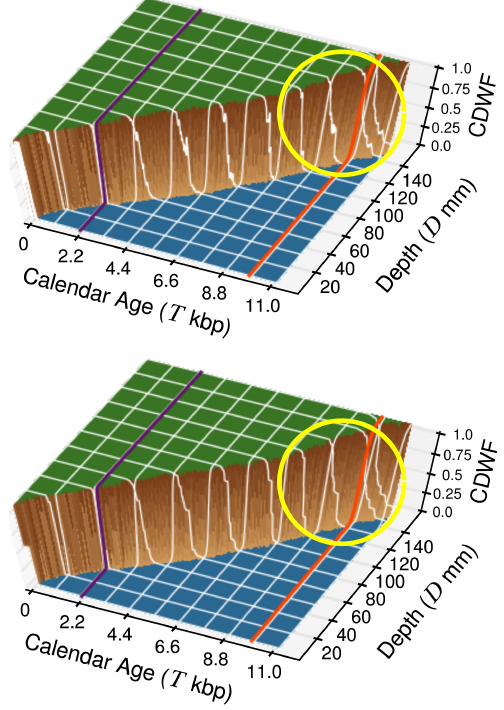
Figure 3. The age–depth sea cliff. (a) The initial CDWF W i ob- tained using Eq. (5), and (b) the final CDWF W f obtained af- Fig. 3. The age-depth sea-cliff. A. The initial CDWF W i obtained ter imposing monotonic growth, for the same example as used in using Eq. 5, and B. the final CDWF W f obtained after imposing Fig. 2. Values of W = 0 are shown in blue and, for W = 1, they are monotonic growth, for the same example as used in Fig. 2. Values shown in green. Intermediate values of W are shown with increas- of W = 0 are shown in blue and W = 1 are shown in green. In- ing darkness from light brown to dark brown, as the value increases termediate values of W are shown with increasing darkness from from 0 to 1. The overlay of white lines over the CDWF surface light brown to dark brown, as the value increases from 0 to 1. The highlights the differences between the pre-monotonicity and post- overlay of white lines over the CDWF surface highlight the differ- monotonicity scenarios. The purple and orange lines are the CD- ences between the pre-monotonicity and post-monotonicity scenar- WFs for the ages 2.2 and 9.5kBP as used in Fig. 2, respectively. The effects of imposing the condition of monotonic growth on the ios. The purple and orange lines are the CDWFs for the ages 2.2 CDWFs is seen more prominently in the white grid lines within the kBP and 9.5 kBP as used in Fig. 2 respectively. The effects of im- marked yellow circles. (Color posing the condition of monotonic growth on the CDWFs is seen more prominently in the white grid lines within the marked yellow circles. (Color online.)